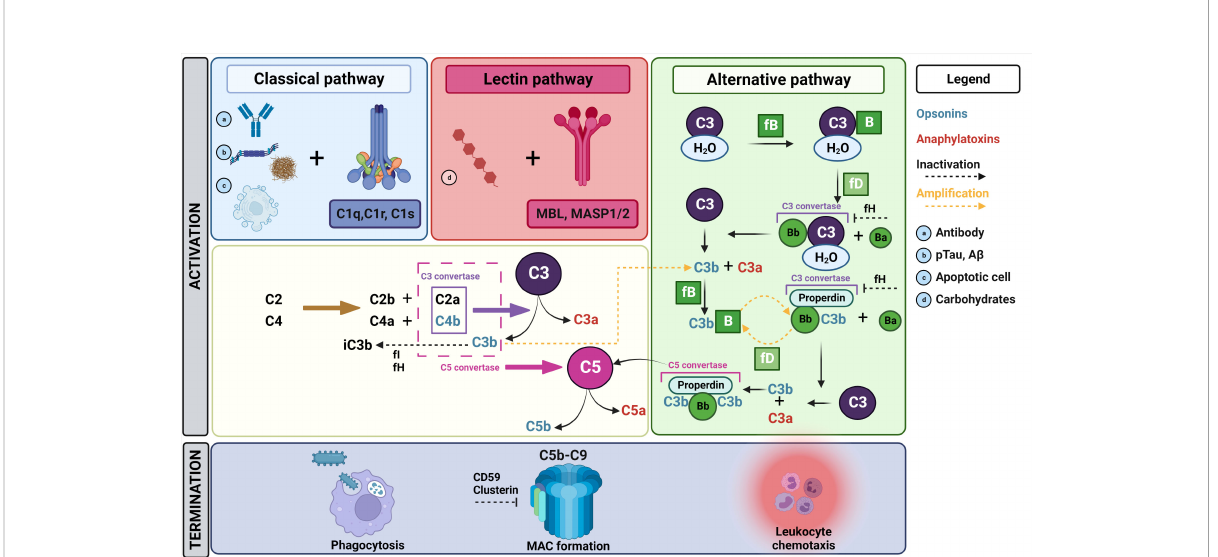
FIGURE 1 Overview of the complement cascade. The complement cascade can be activated via three different pathways. In the classical pathway, the C1 complex (C1r, C1s, C1q) recognizes antibody complexes (A) bound to pathogens, polyanionic molecules such as pTau and A b (B) or damage- associated patterns on apoptotic cells (C) . Following C1 activation, C2 and C4 will be converted to C2a/b and C4a/b, respectively. C2a and C4b complex together and form a C3 convertase, which will cleave C3 to create C3a and C3b. Subsequently, C3b will complex with C2aC4b to